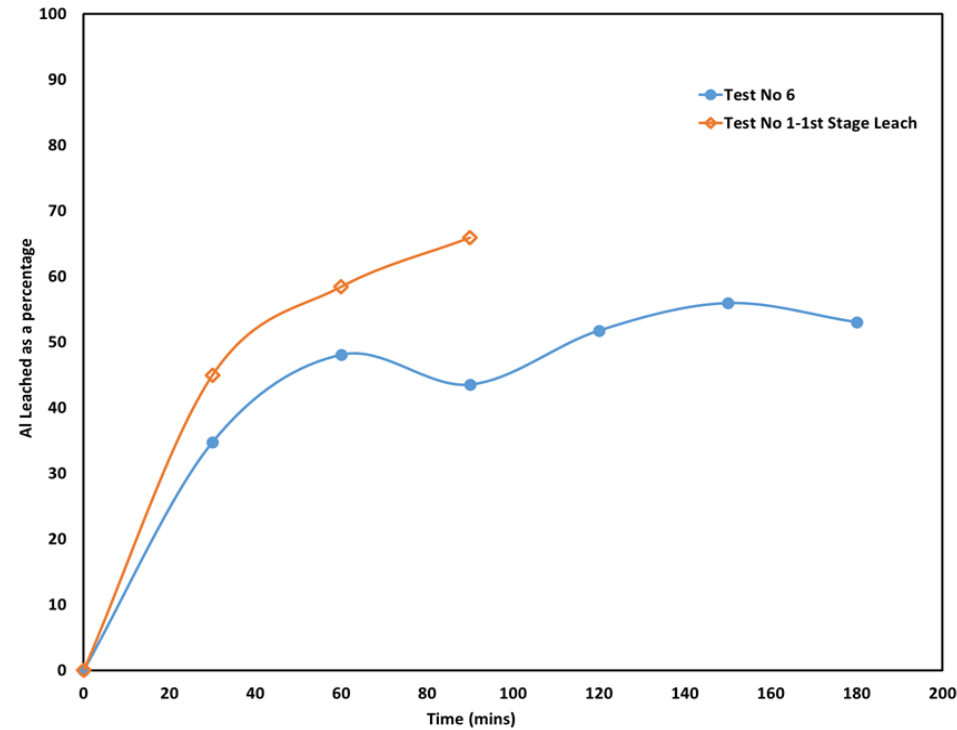
Figure 9 . Test no. 6 leaching of 100 g of slag 1L of 80 g/L Na 2 CO 3 .